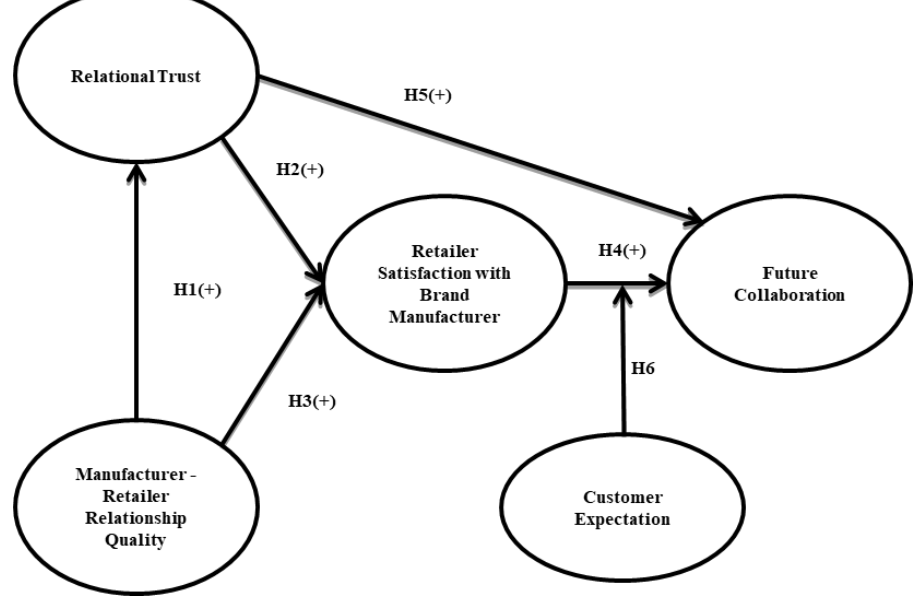
Figure 1. Conceptual framework of research.